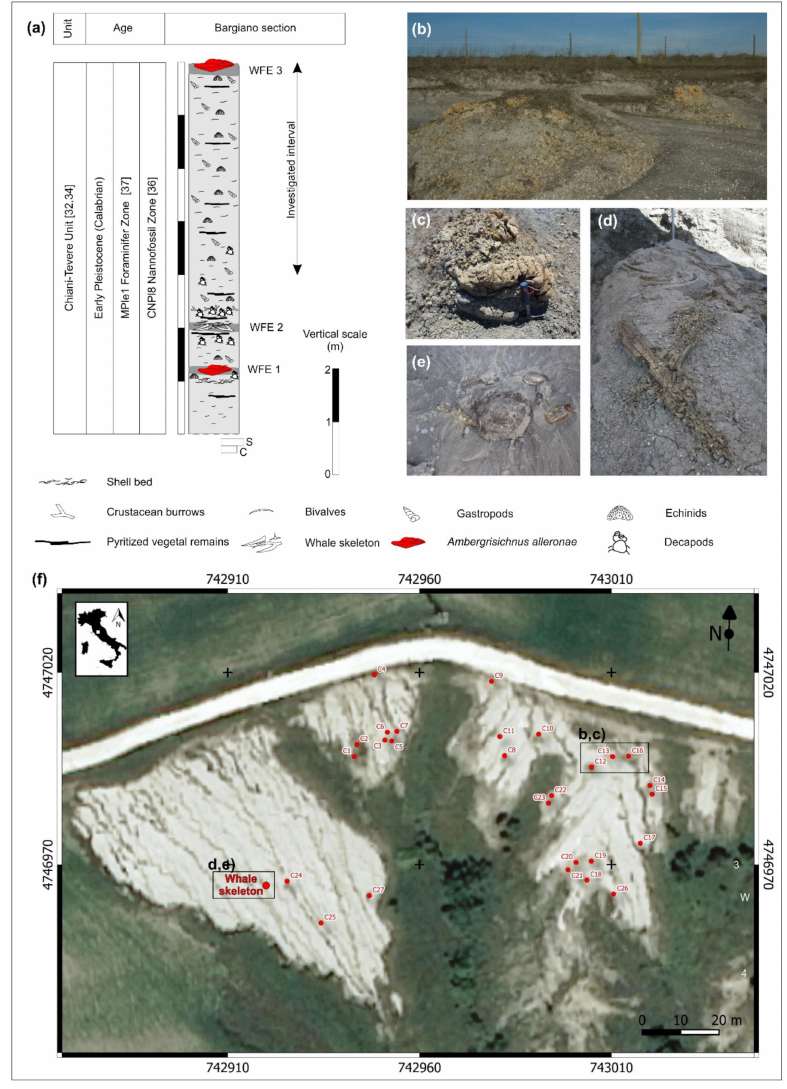
Figure 2. General geo-paleontological overview of the Bargiano site; ( a ) composite stratigraphic section. ( b , c ) Aspect of Ambergrisichnus cololites in the field (WFE3); ( d , e ) fossils from the Bar- giano site: ( d ) Whale skeleton, WFE2, ( e ) crab; ( f ) spatial distribution of largest Ambergrisichnus structures (red dots numbered from 1 to 27, data derived from [30]) and of cetacean skeleton: rect- angles indicate position of photos in figures (orthophoto by Regione Umbria—URL: http://geo. umbriaterritorio.it/arcgis/services/public/ORTOFOTO_2011_WGS84/MapServer/WMSServer, ac- cessed on 8 July